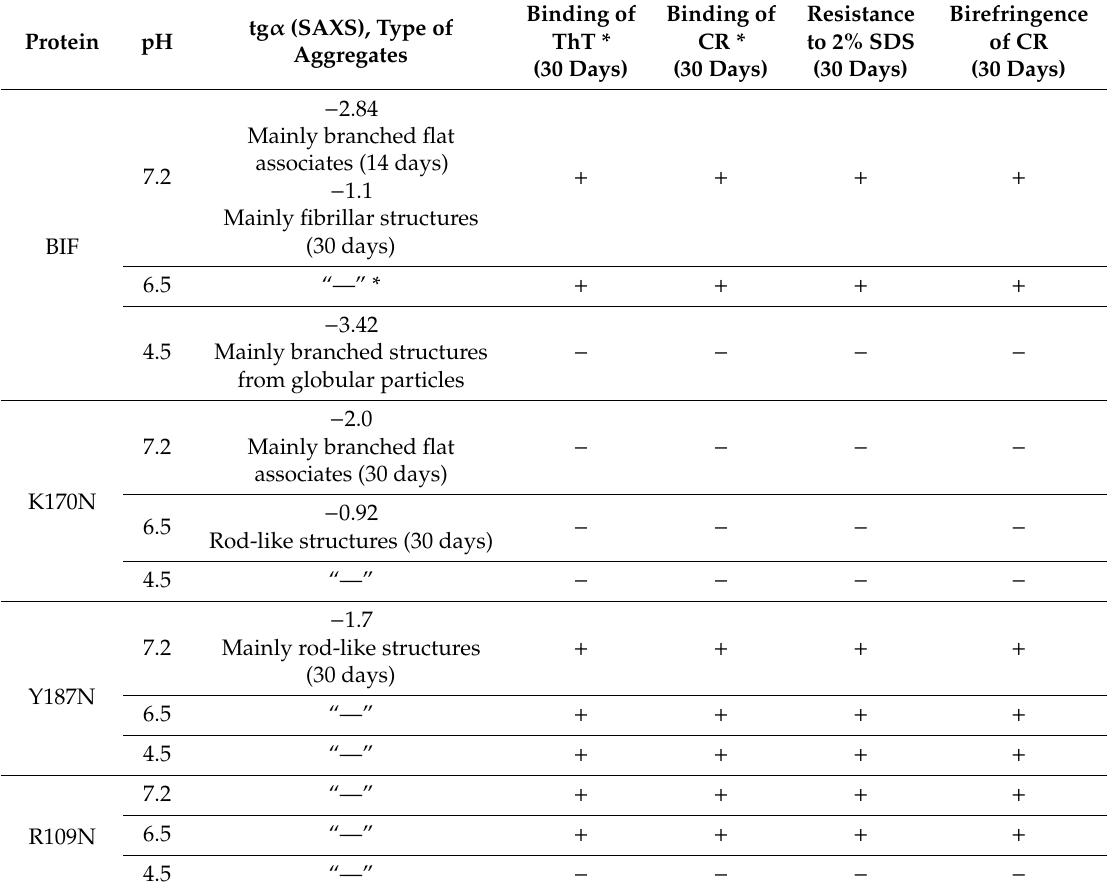
Table A1. The comparative characteristics of proteins